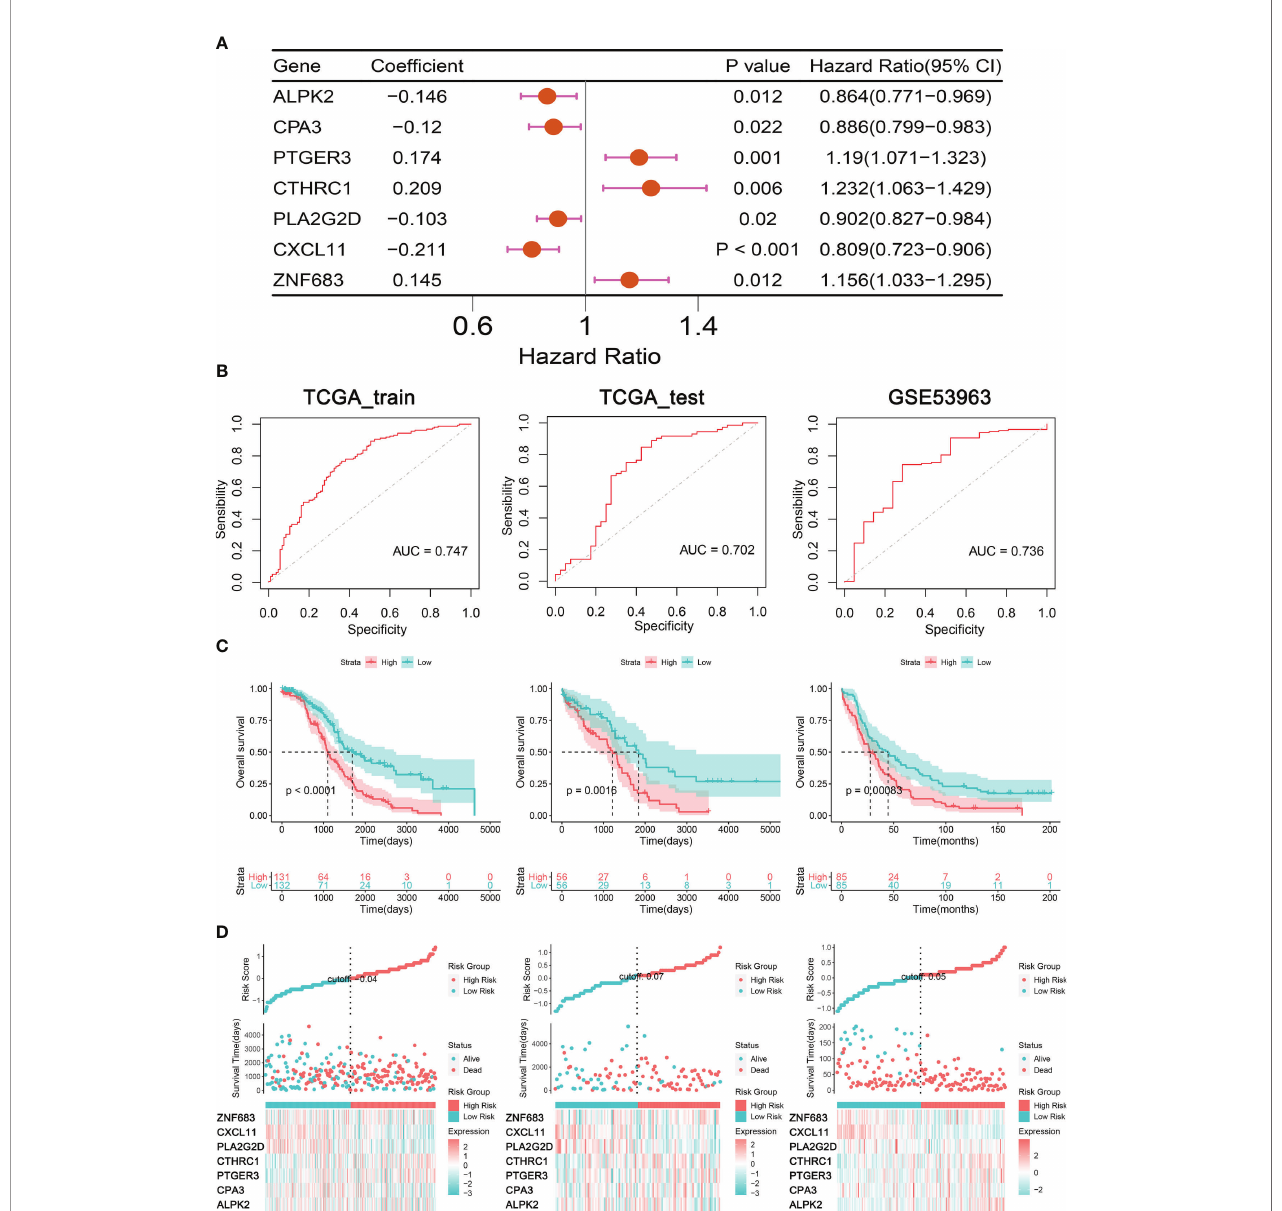
FIGURE 4 | Construction and Validation of Prognostic Signatures for TIME regulators. (A) Forest plot presents the seven genes related to TIME. (B) ROC curves analysis of TIMErisk with OS in OC patients of TCGA training, testing, and GSE53963 cohorts. (C) Kaplan-Meier curve analysis of TIMErisk with OS in OC patients of TCGA training, testing, and GSE53963 cohorts. (D) A group of risk plots for TCGA training, testing, and GSE53963 cohorts, including the heatmap of TIME regulators ’ expression and the distribution of patients ’ survival